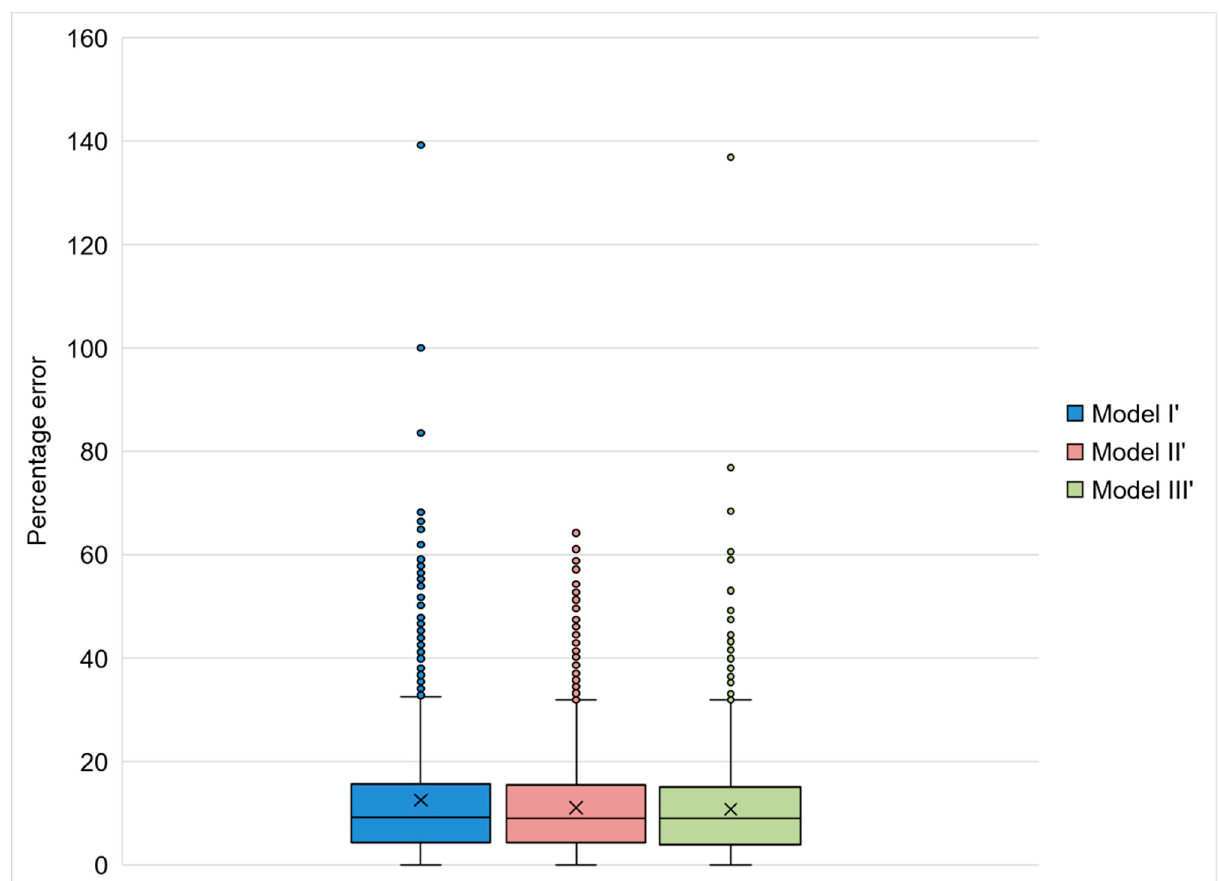
Figure 10. Boxplot indicating the MAPE distribution in Models I’, II’, and III’. The box represents data between the 2nd and 3rd quartiles. Vertical bars indicate the 1st and 4th quartiles, and the circles represent the outliers. The × inside the box indicates the mean value, and the horizontal bar indicates the median value.